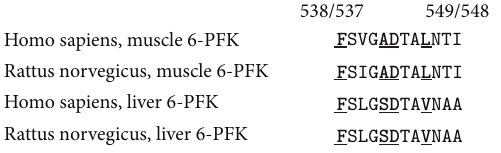
Figure 3: Alignment of the linear part of the predicted ethanol- binding site for muscle (amino acids 538–549) and liver (amino acids 537–548) rat and human phosphofructokinases. Amino acid residues interacting with ethanol according to the results of molec- ular docking are shown by bold underlined